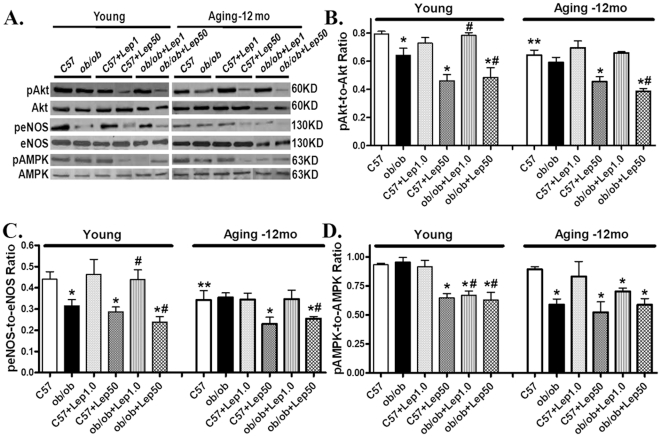
Panel A: Representative gel blots of total and phosphorylated Akt,
eNOS and AMPK in cardiomyocytes freshly isolated from young
(4-month-old) or aging (12-month-old) lean (C57) and
ob/ob mice treated with or without leptin (1.0 and
50 nM) for 4 hrs using specific antibodies; Panel B: Phosphorylation of
Akt expressed as pAkt-to-Akt ratio; Panel C: Phosphorylation of eNOS
expressed as peNOS-to-eNOS ratio; and Panel D: Phosphorylation of AMPK
expressed as pAMPK-to-AMPK ratio.Mean ± SEM, n = 4 –
6 isolations, * p<0.05 vs. respective
C57 group, ** p<0.05 vs. young
C57 group, # p<0.05 vs. respective
ob/ob group.